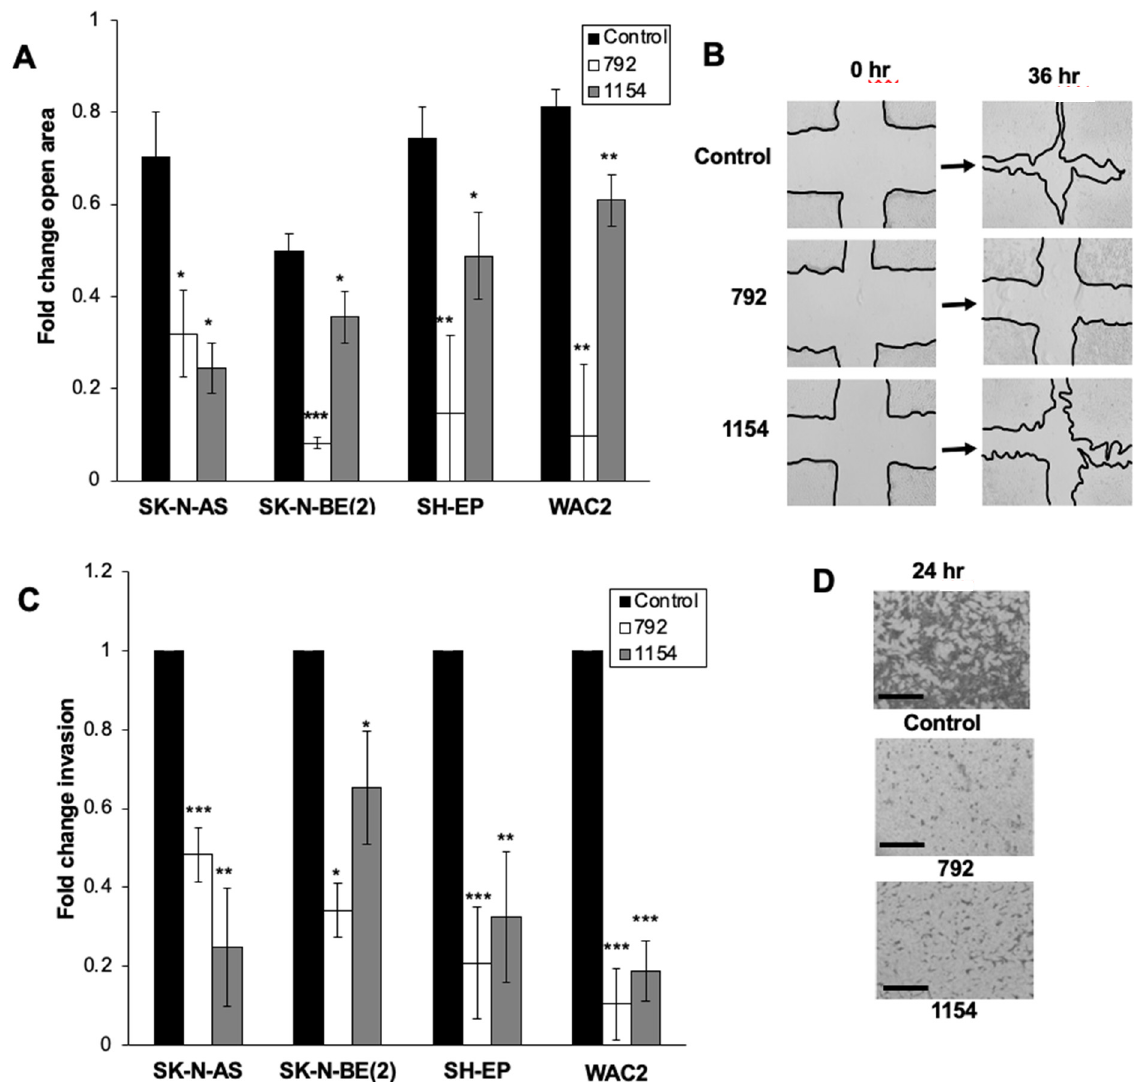
Figure 5. Treatment with 792 or 1154 decreased neuroblastoma migration and invasion. ( A ) For migration, neuroblastoma cells were plated and treated with 792 (SK-N-AS 10 μ M; SK-N-BE(2), SH-EP, WAC2 15 μ M) or 1154 (SK-N-AS, SK-N-BE(2) 10 μ M; SH-EP, WAC2 15 μ M). Cells were allowed to reach 80% confluence, and a standard scratch was made in the plates. Images of each well were taken at 0, 12, 24, and 36 h. The open wound area was analyzed using ImageJ. At 36 h of treatment, there was a significant decrease in cell migration compared to untreated cells. ( B ) Representative images of scratch assay at 0 and 36 h following treatment with 792 or 1154. ( C ) To evaluate invasion,